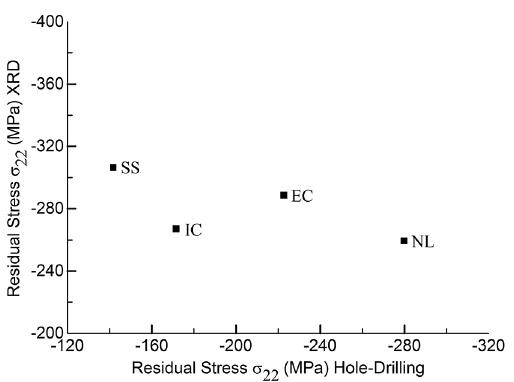
measured by XRD and Hole-Drilling. 22